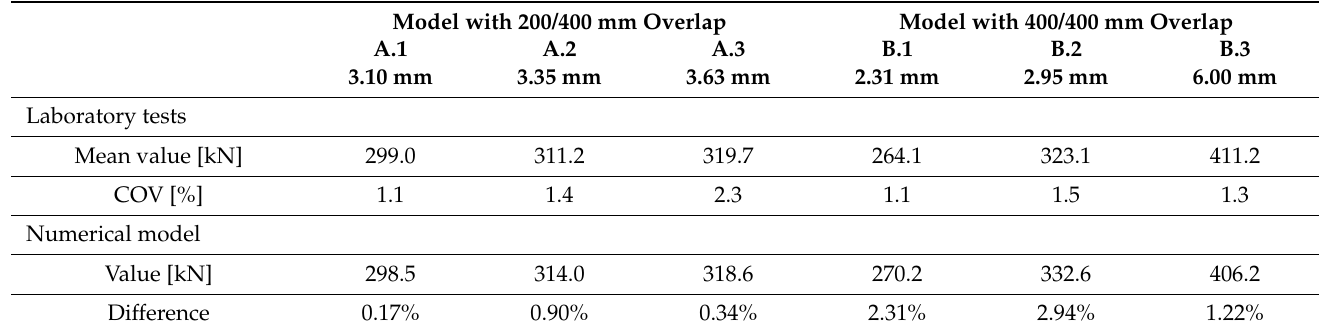
Table 4. Tensile and shear properties of